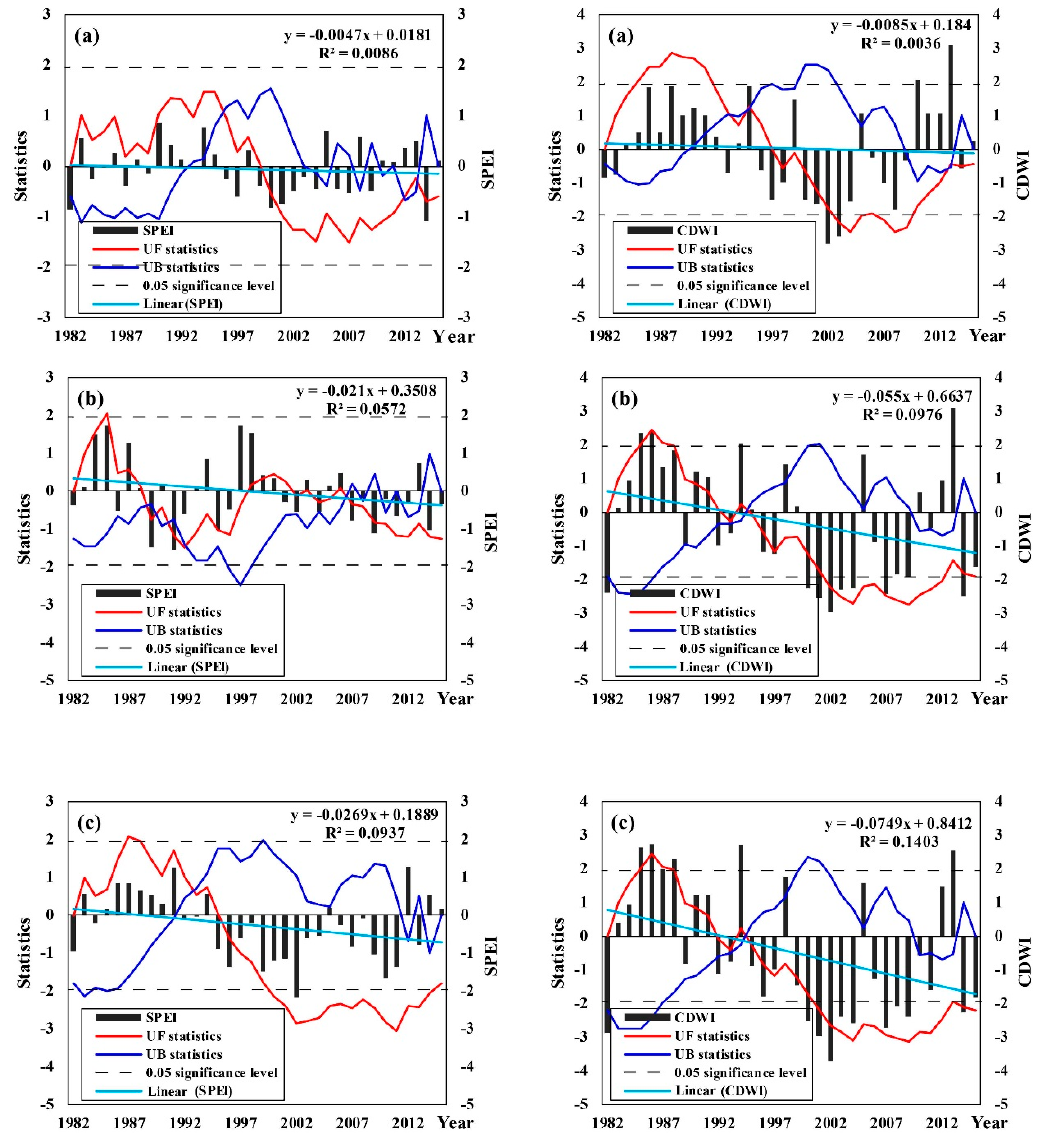
Figure 4. Variation tendency of the SPEI and CDWI at different time scales from 1982 to 2015 in Midwestern Jilin Province. ( a – c ) Represent the stages of emergence-tasseling stage, tasseling-milky maturity, and milky maturity-mature, respectively.